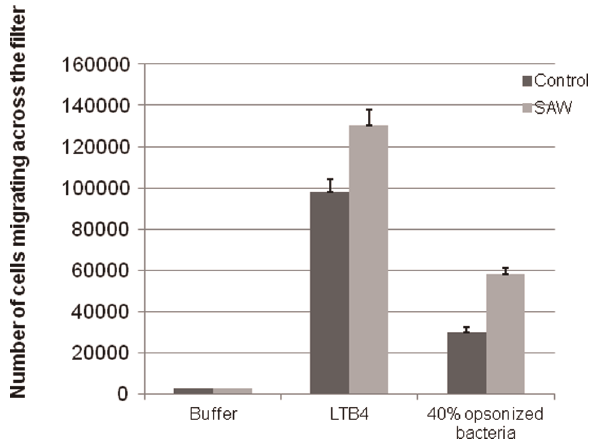
Figure 3. Neutrophil chemotaxis in response to LTB4 and opsonized bacteria. Neutrophil chemotaxis was measured as described [16]. Where indicated, the chambers were exposed to SAW for 6 hr immediately after the addition of the human neutrophils to the upper compartment of the transwell chemotaxis chambers as described under Materials and Method [16]. The bottom compartments contained 0.5 mL of either PBS-G-HSA, buffer alone, or buffer supplemented with 10 2 7 M LTB4 or 10 8 CFU S. epidermidis opsonized with 40% human serum. Values represent the number of cells in the lower compartment 6 SEM of n=3 experiments performed in duplicates. *Difference between control and SAW treated cells is significant at p , 0.05 level when either LTB4 or opsonized bacteria were added as chemoattrac- tants to the lower compartment.